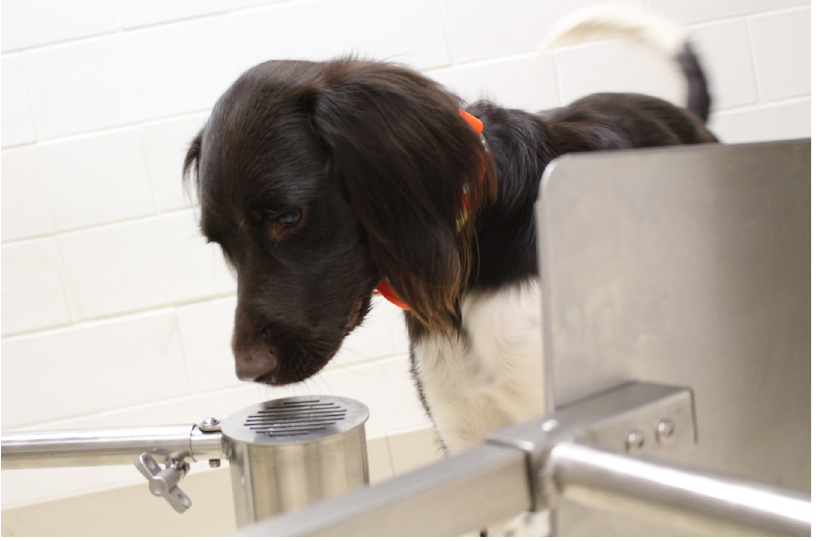
Fig 3. Detection dog Toby giving a final response (stand-stare) at target